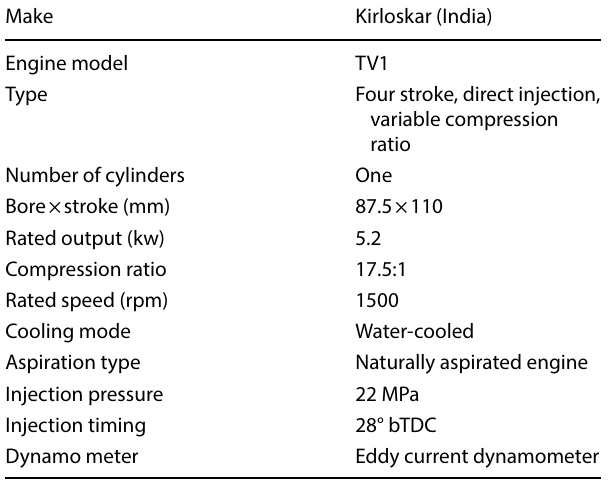
Fig. 2 Schematic representa- tion of test engine